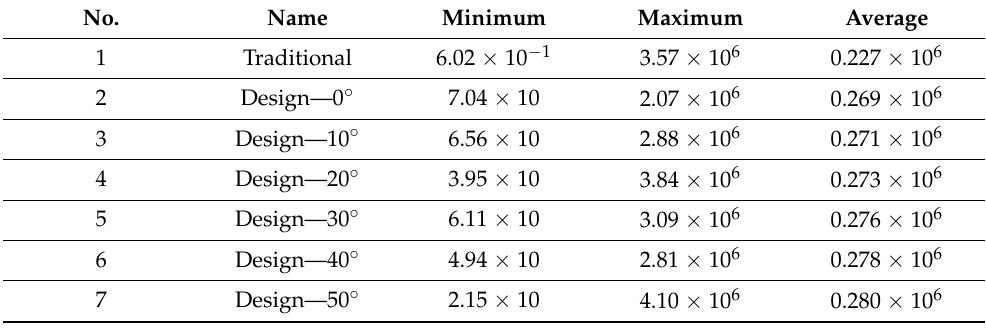
Table 3. Von Mises stress (N/m 2 ) of each plate.